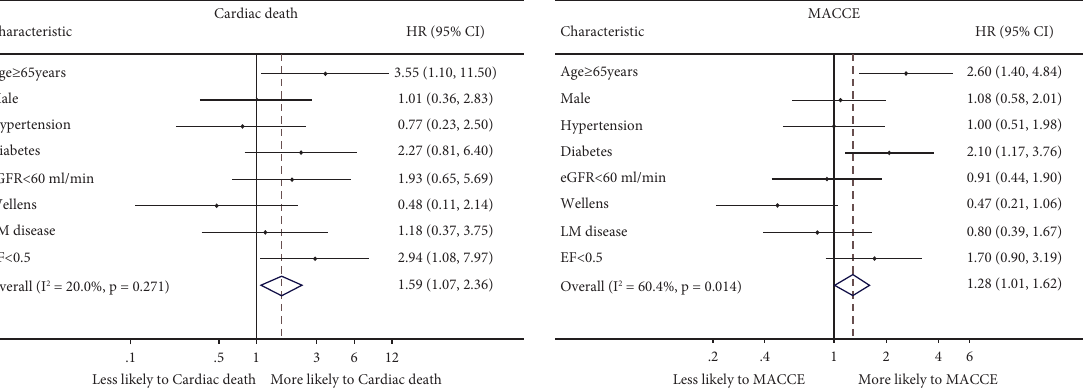
Figure 3: Factors independently associated with cardiac death and MACCE in overall patients in multivariable Cox regression